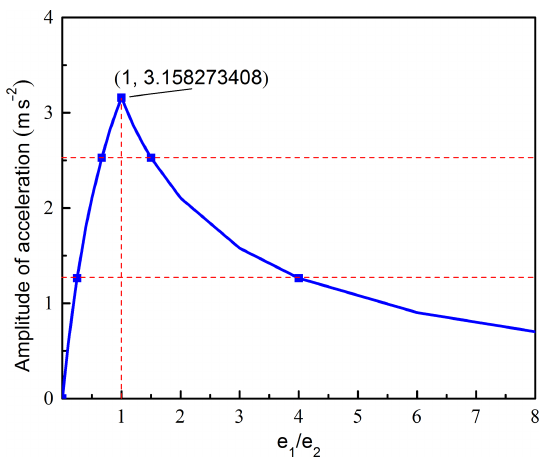
Figure 9. Effects of e 1 /e 2 on the amplitude when ω 1 = − ω 2 ( e 1 + e 2 = 2 e ).